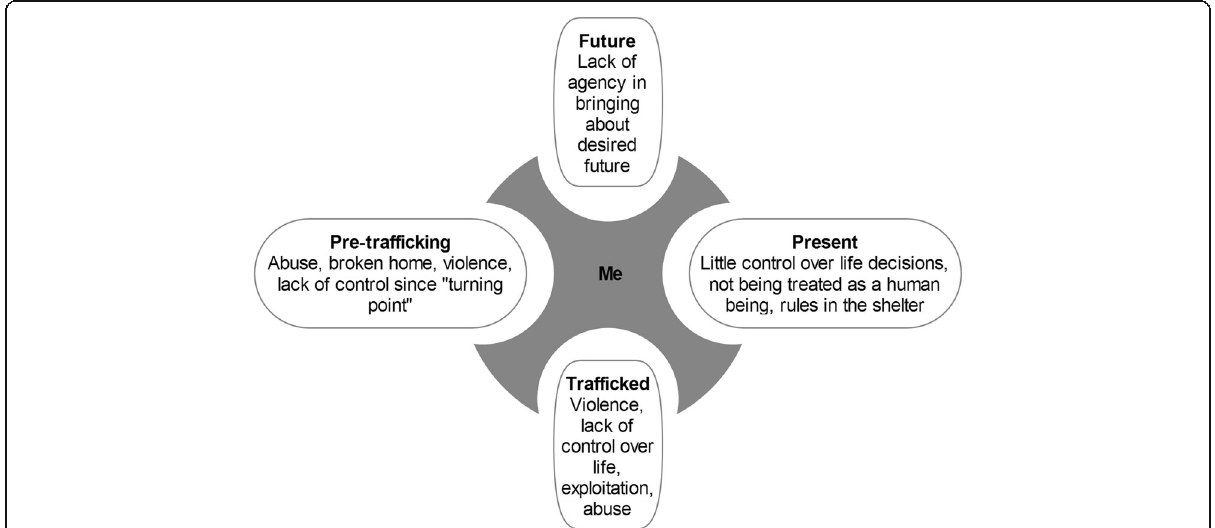
Fig. 1 Loss of autonomy in various phases of the lives of trafficked persons. The figure shows the various phases and examples of external negative regulators that give rise to experienced loss of